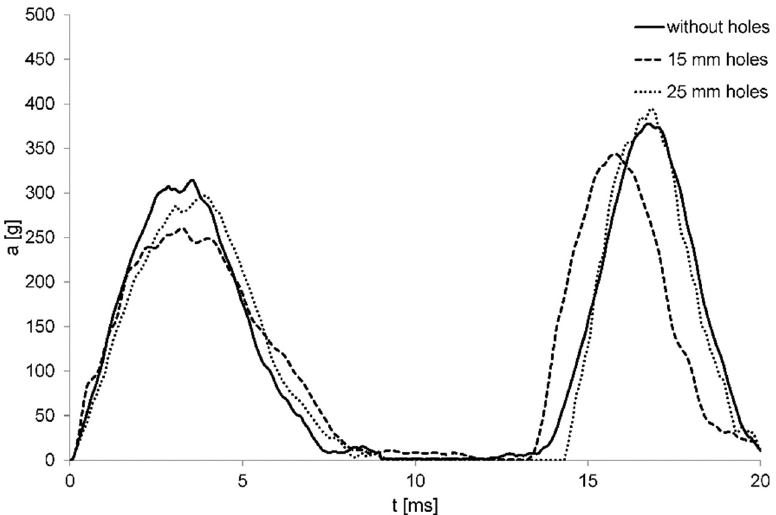
Figure 9. Acceleration response of the bulk and holed versions of agglomerated cork liners (Reprinted with permission from [67]).